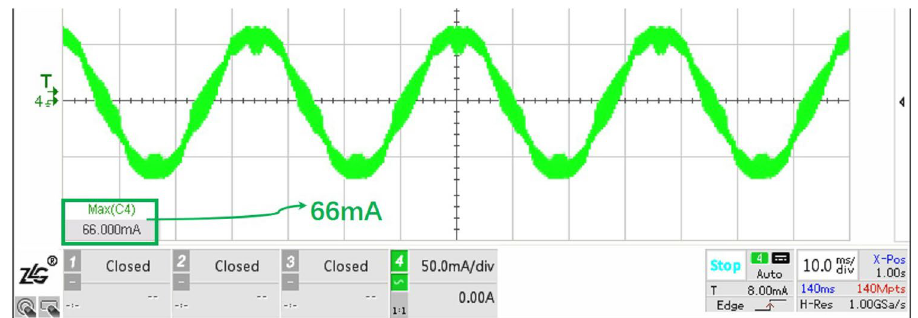
Figure 18. Peak current tested under V bus equaling 1.8 V.